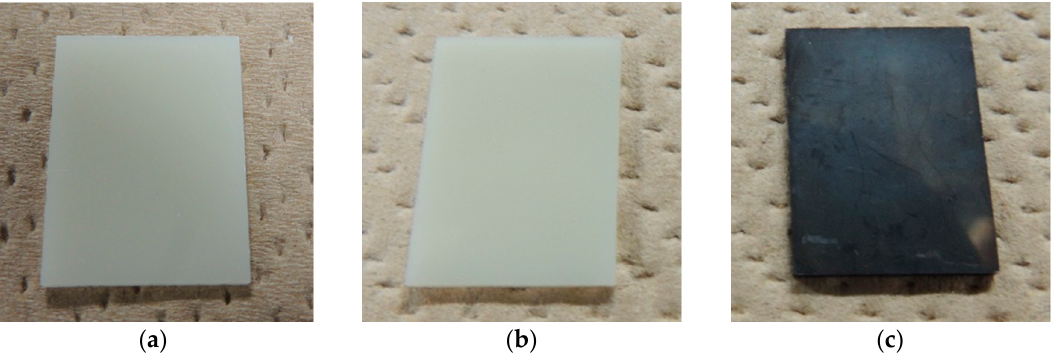
Figure 1. Photographs of the acrylonitrile–butadiene–styrene copolymer (ABS) samples: ( a ) untreated ABS; ( b ) Pt-particle/ABS; and ( c ) Pt-film/ABS.